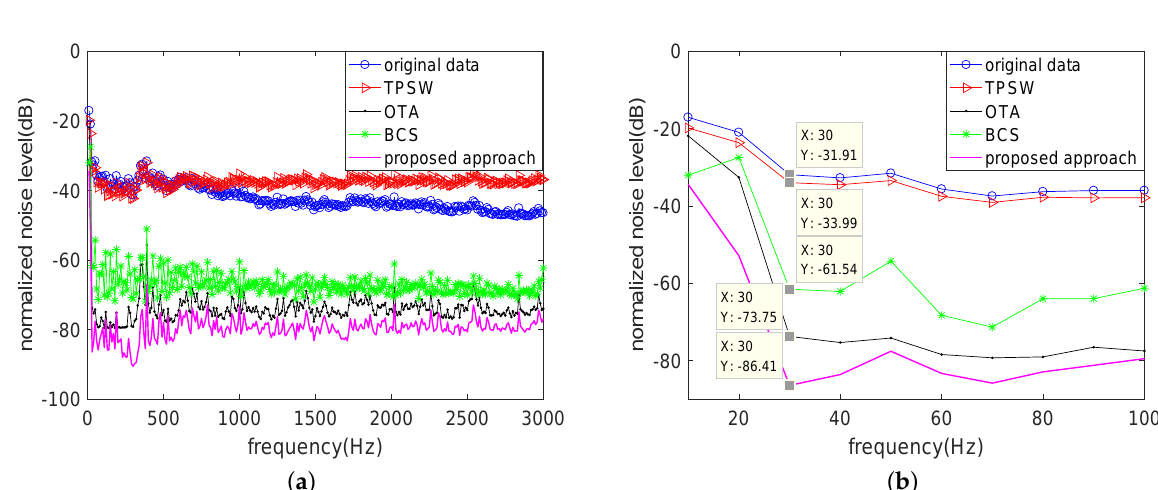
Figure 6. ( a ) Comparison of normalized noise level in different algorithms; ( b ) a magnified version of ( a ) at 10 ∼ 100 Hz.